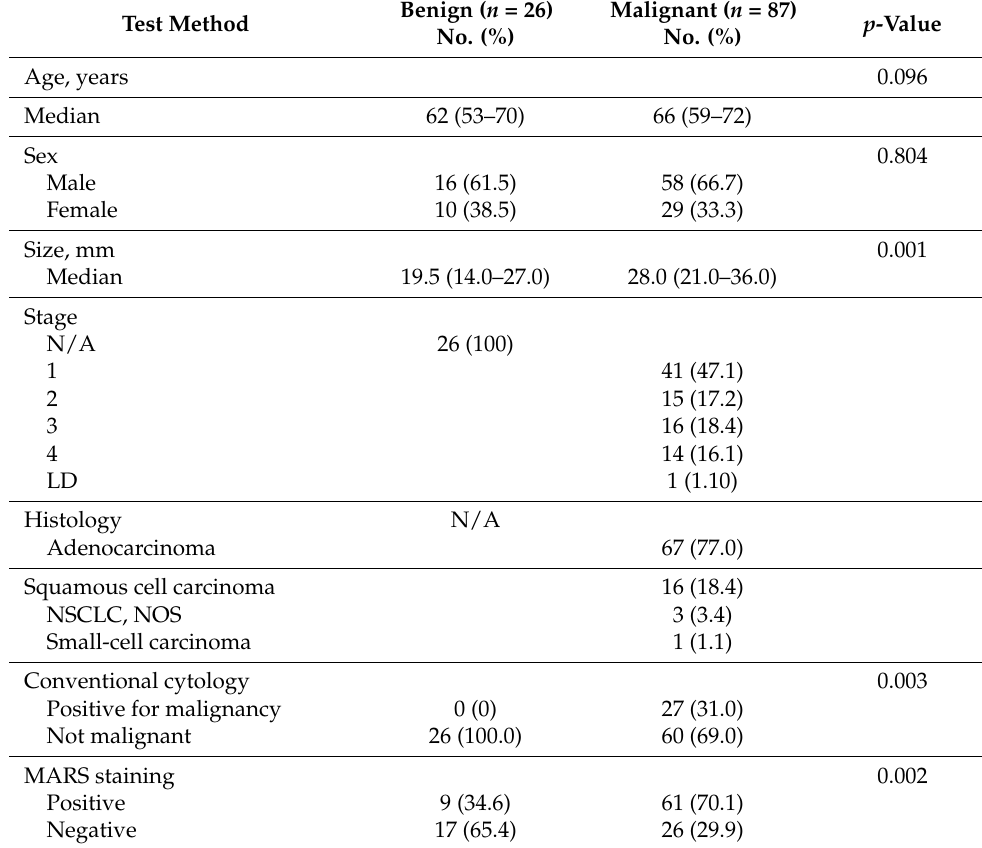
Table 1. Baseline patient